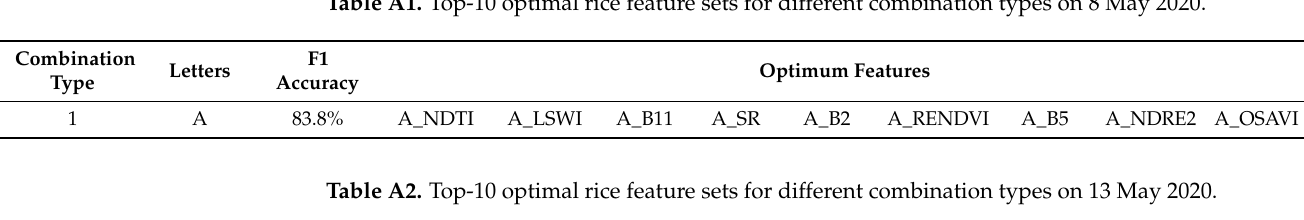
Table A1. Top-10 optimal rice feature sets for different combination types on 8 May 2020.